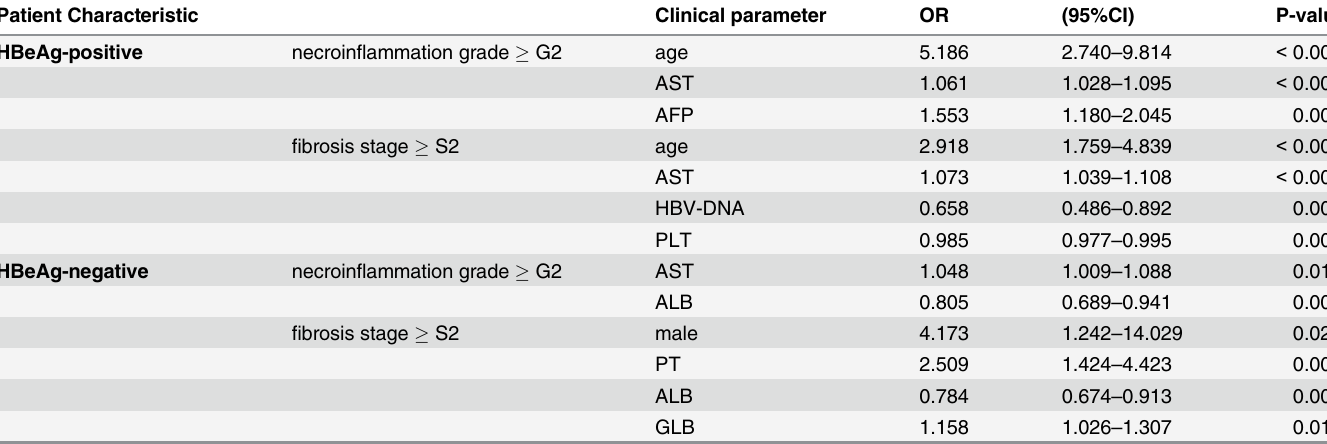
Table 3. Multivariate analysis of clinical parameters independently associated with significant histological abnormalities. Patient